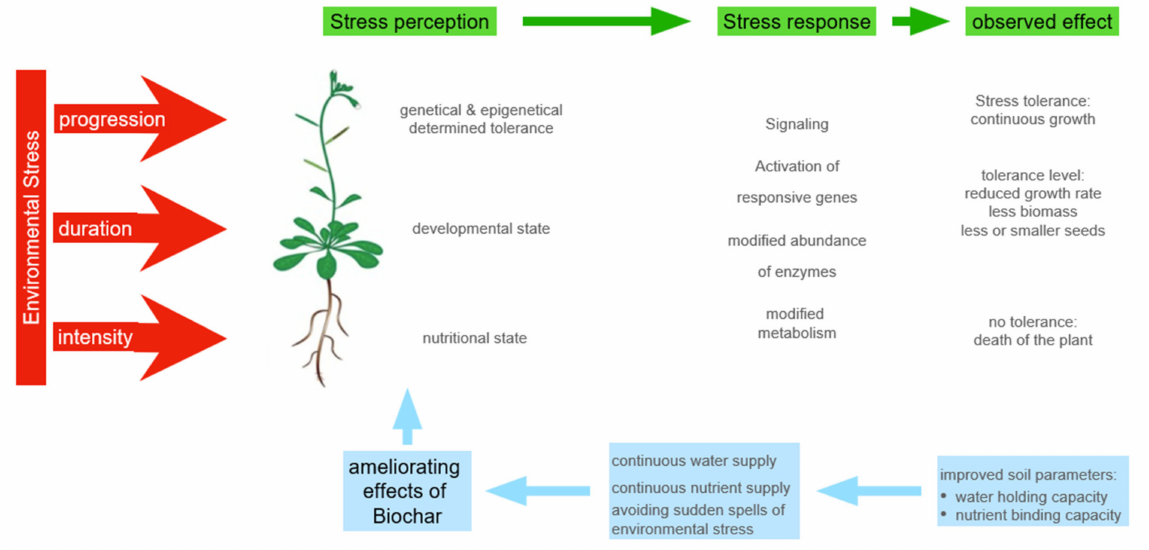
Figure 3. How biochar is improving the stress tolerance of